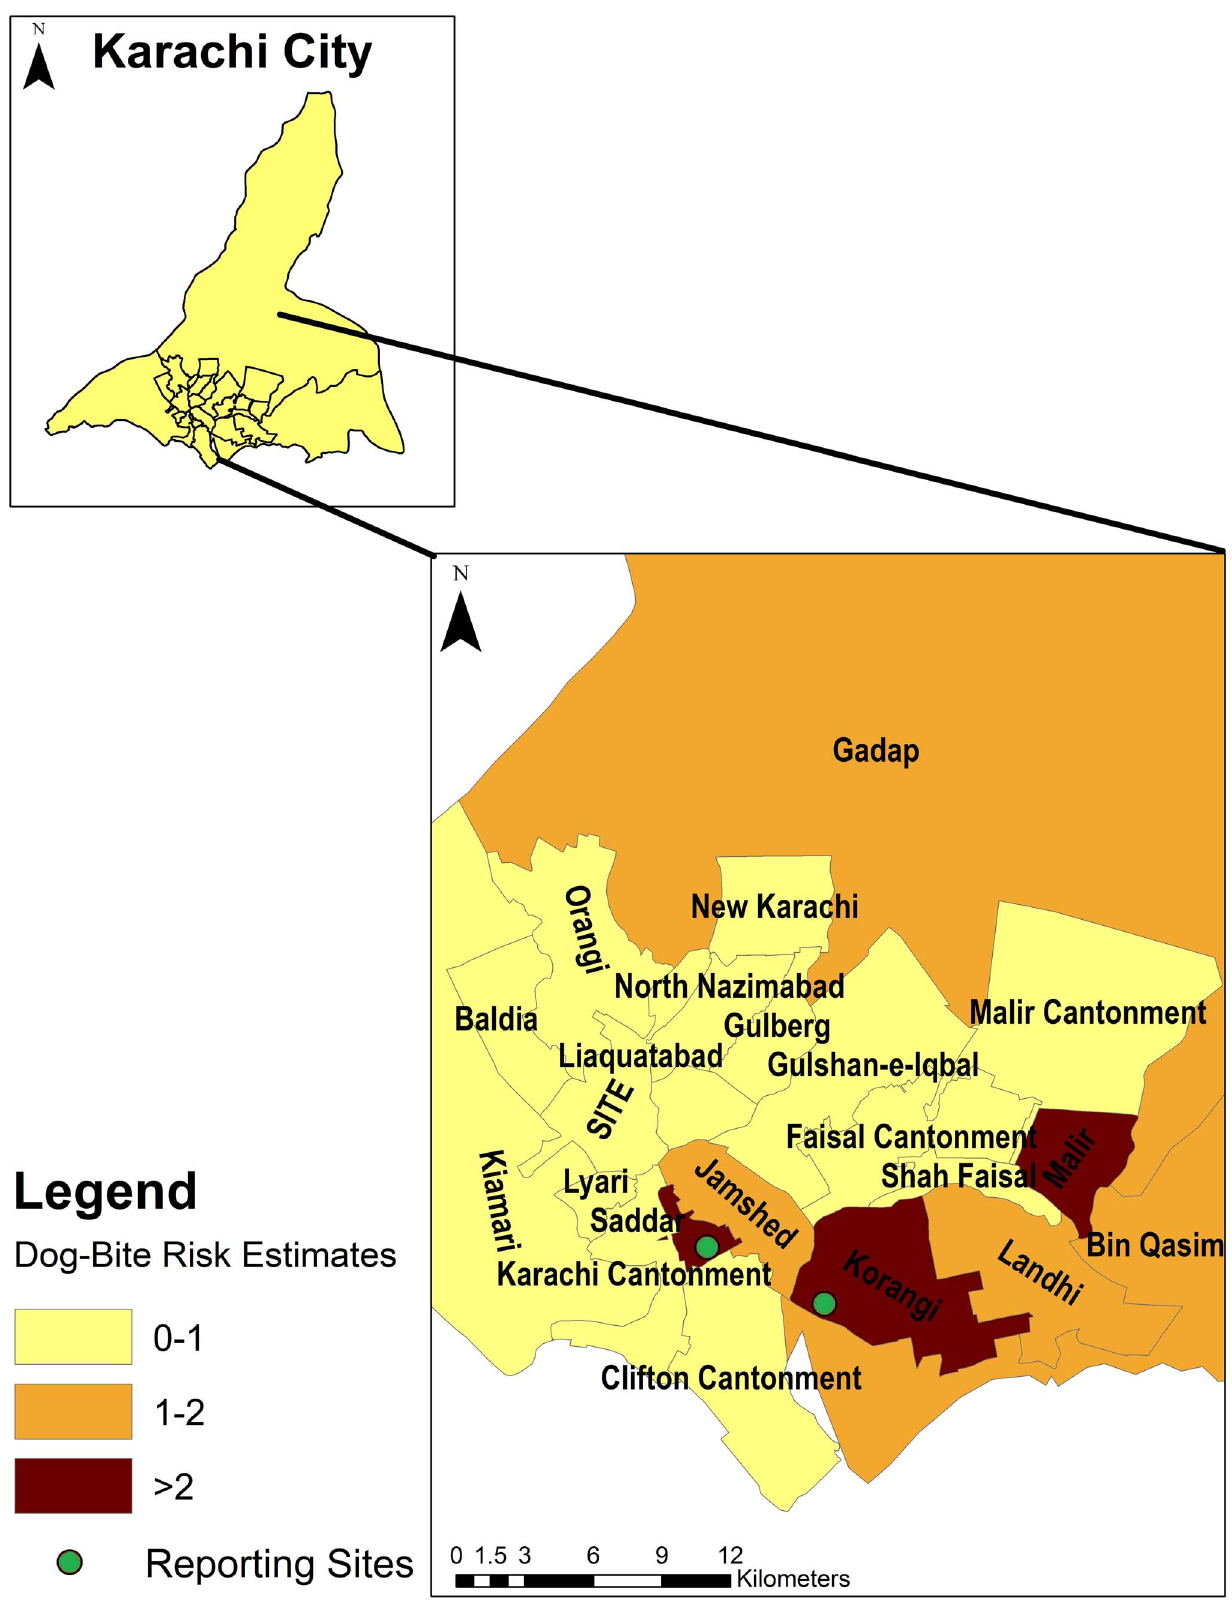
Figure 4. Risk estimates of dog-bites by administrative towns in Karachi, Pakistan between Feb 2009–Feb 2011.